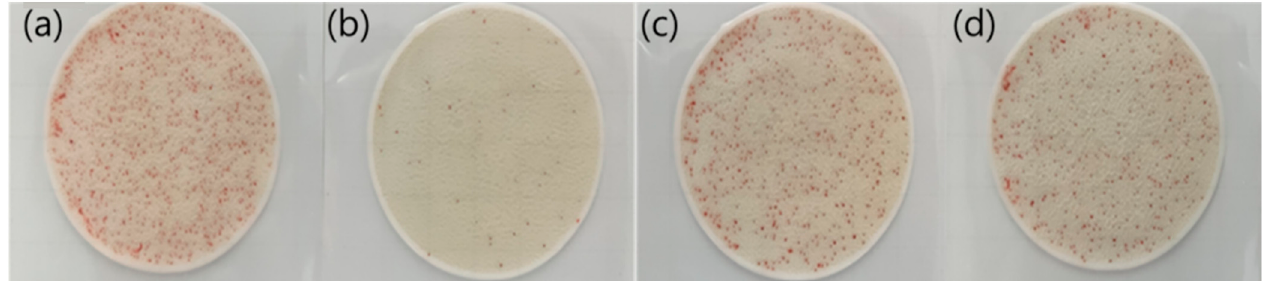
Figure 3. Antibacterial activity of ( a ) control, ( b ) NaOH sample ( c ) NH 3 sample, and ( d ) 80 °C treated NaOH sample. Table 1. Average colony number of